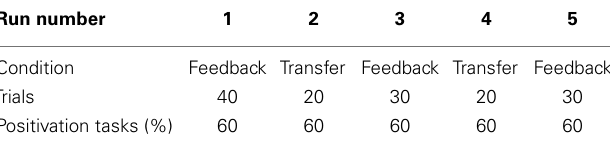
Table 3 | Composition of tasks and conditions during one session .